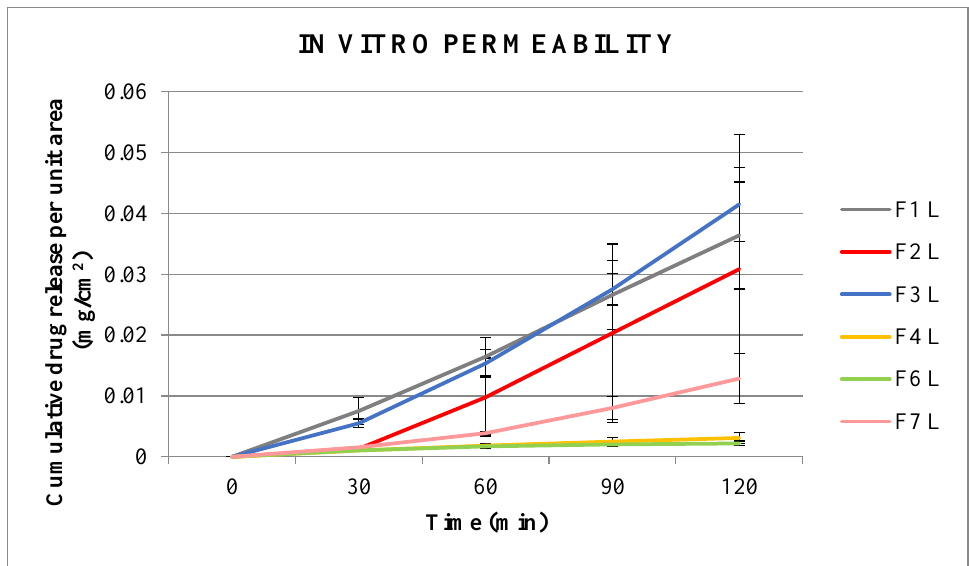
Figure 3. In vitro permeability of lidocaine for the various formulation of NIO-HAMIN emulgels. (P: prilocaine; L: lidocaine).